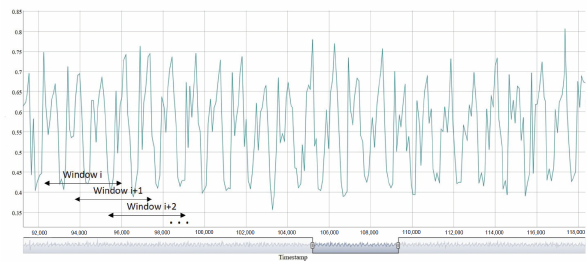
Figure 3. Example of sample windowing.